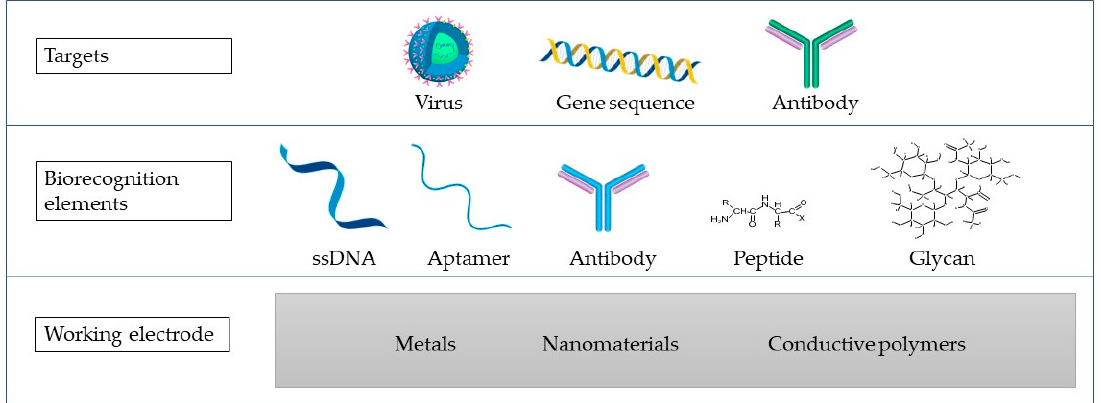
Figure 2. A biosensor scheme containing the WE made of different materials (metals, nanomaterials, or conductive polymers), biorecognition elements, and the targets that are commonly targeted in virus detection using the impedimetric biosensors.